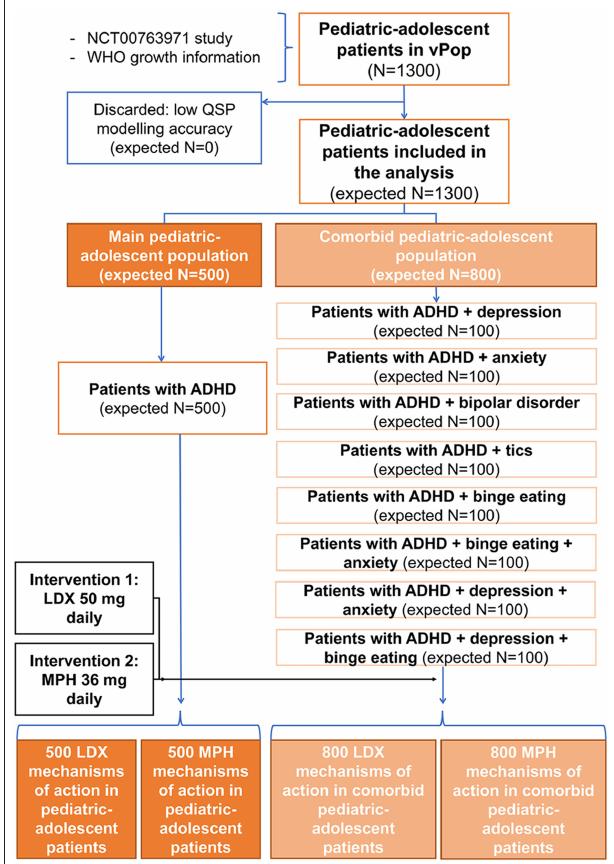
FIGURE 3 | Comorbidities distribution and treatment allocation in the adult virtual population. ADHD, Attention-deficit/hyperactivity disorder; LDX, Lisdexamfetamine; MPH, Methylphenidate; QSP, Quantitative systems biology; vPOP, Virtual population.